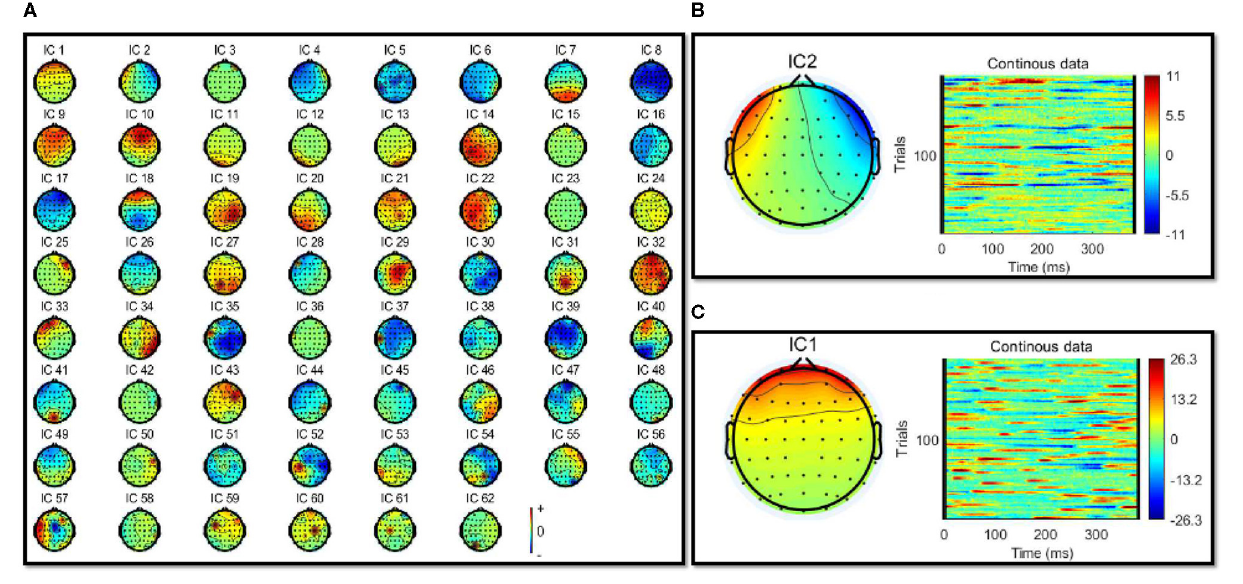
Frontiers in Human Neuroscience |